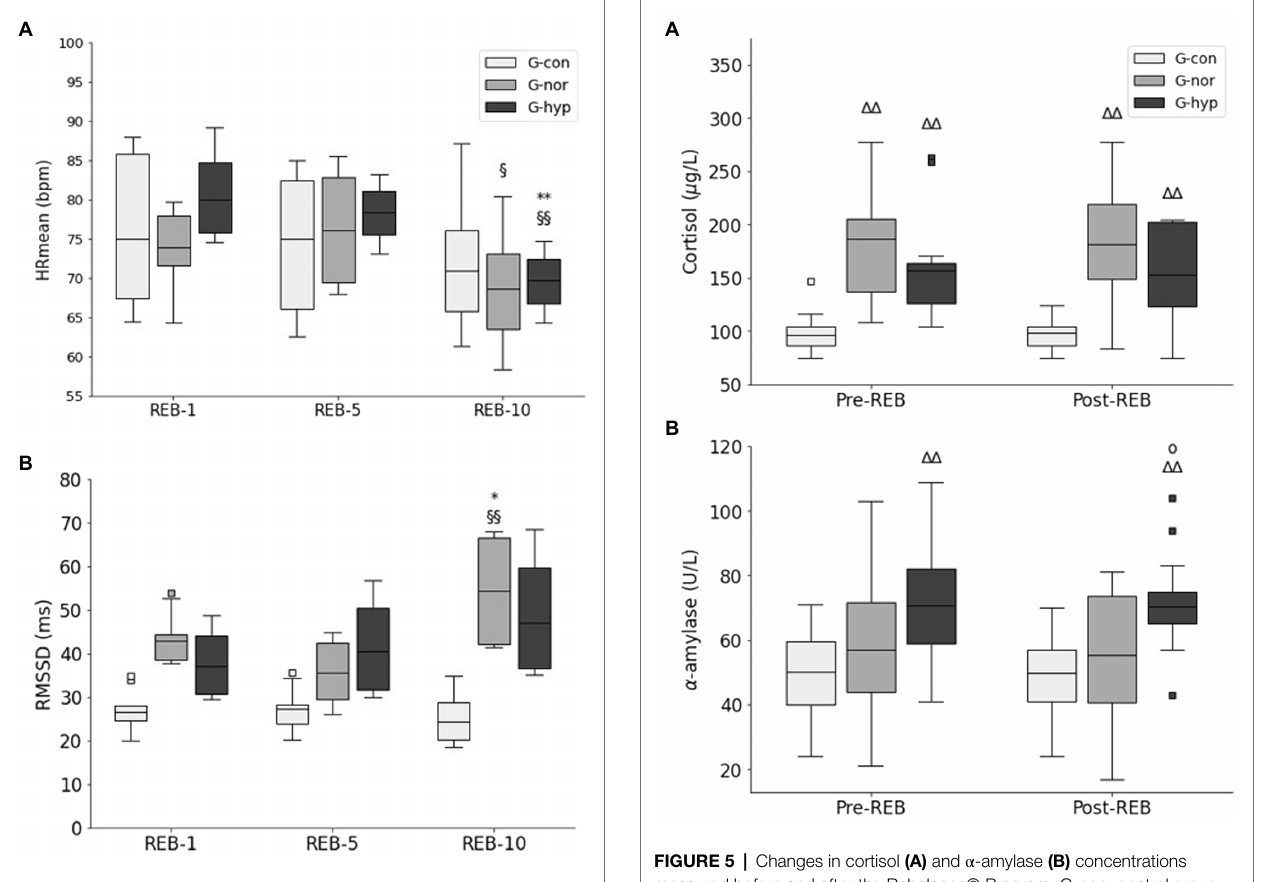
FIGURE 4 | Changes in HRmean (A) , RMSSD (B) throughout the Rebalance© Program. G-con, control group; G-nor, normotensive group; G-hyp, hypotensive group. REB-1, − 5, − 10, Rebalance© session number 1, 5, and 10, respectively. HRmean, average heart rate during HRV measurement; HRV, heart rate variability; RMSSD, root-mean square difference of successive normal heart beats. Box plots represent median interquartile range (IQR, Q25–Q75), and error bars are maximal and minimal observations within 1.5 × IQR. Squares represent maximum and minimum observations above or below 1.5 × IQR. * and ** Significantly different from REB-1 ( p < 0.05 and p < 0.01, respectively); § and §§ Significantly different from REB-5 ( p < 0.05 and p < 0.01, respectively).